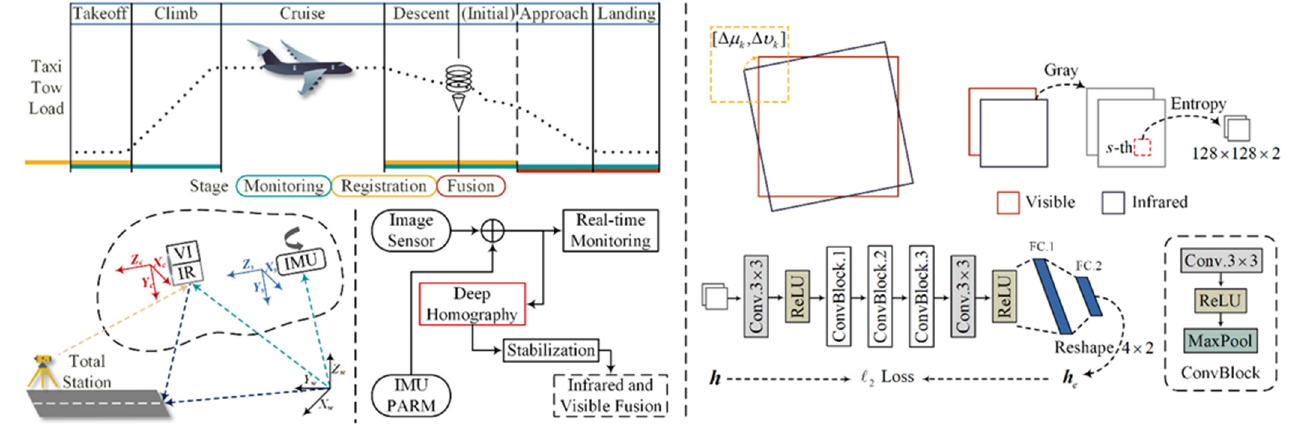
Figure 3. Graphic of flight stages and deep homography estimation (The calibration process is mainly implemented on the ground and before landing).